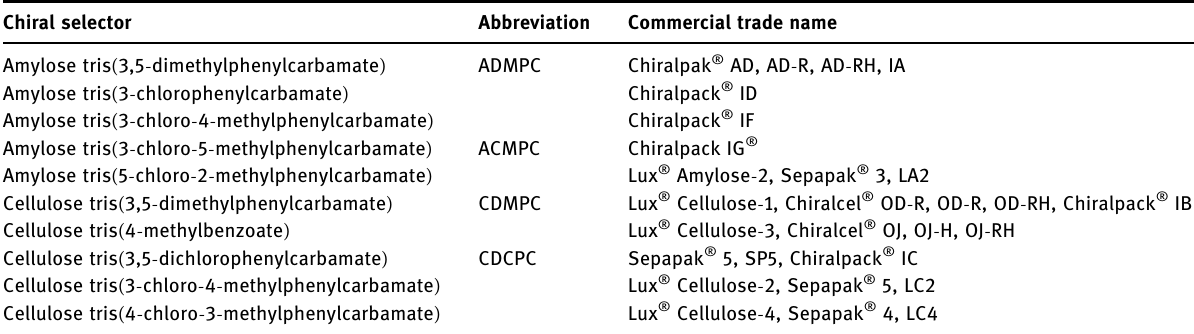
Table 1: Classi fi cation of CSPs polysaccharides - based and commercial trade name Chiral